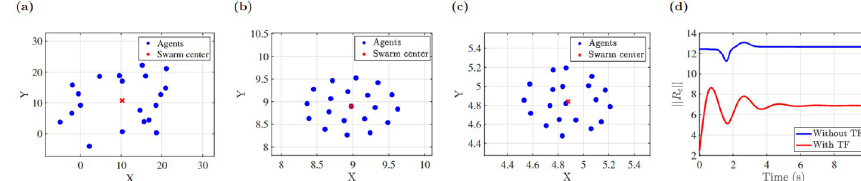
Fig 11. (a) Initial condition of 20 agents, (b) cluster shape with measured delays, (c) cluster shape with both identified transfer functions and delays, (d) swarm center